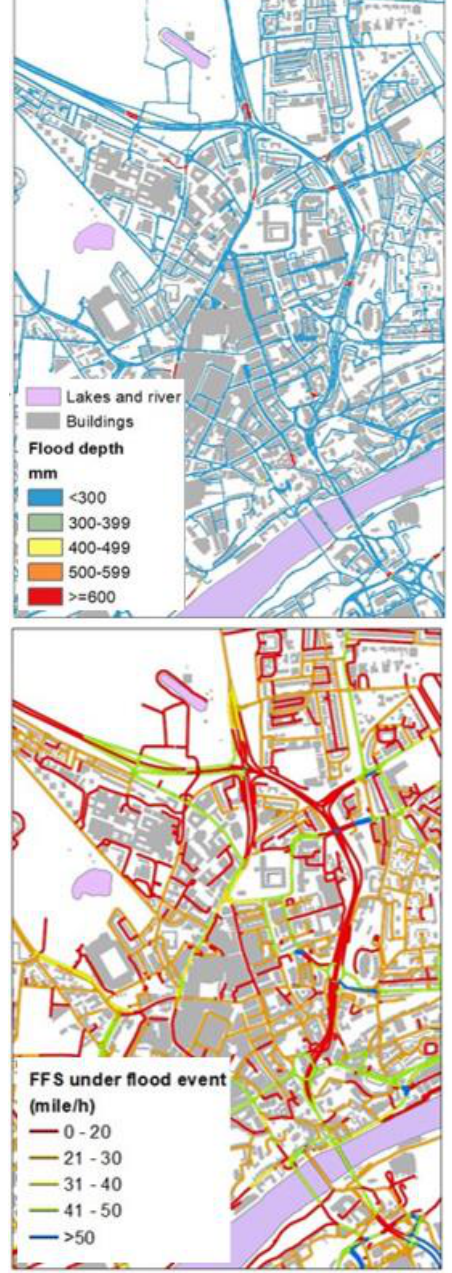
Figure 4. Flooded roads predicted by the HiPIMS surface water flood model and resultant impacts on free-flow traffic speeds for part of the city of Newcastle upon Tyne UK.